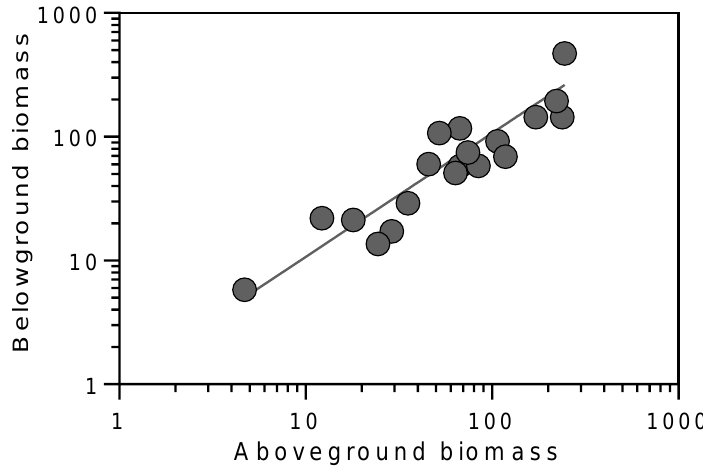
Fig. A1. Relationship between aboveground perennial biomass (g Dry Matter) and the corresponding belowground biomass (g Dry Matter). The belowground biomass is the sum of biomass values for root crown, roots greater than 5 cm, roots ranging from 1 to 5cm